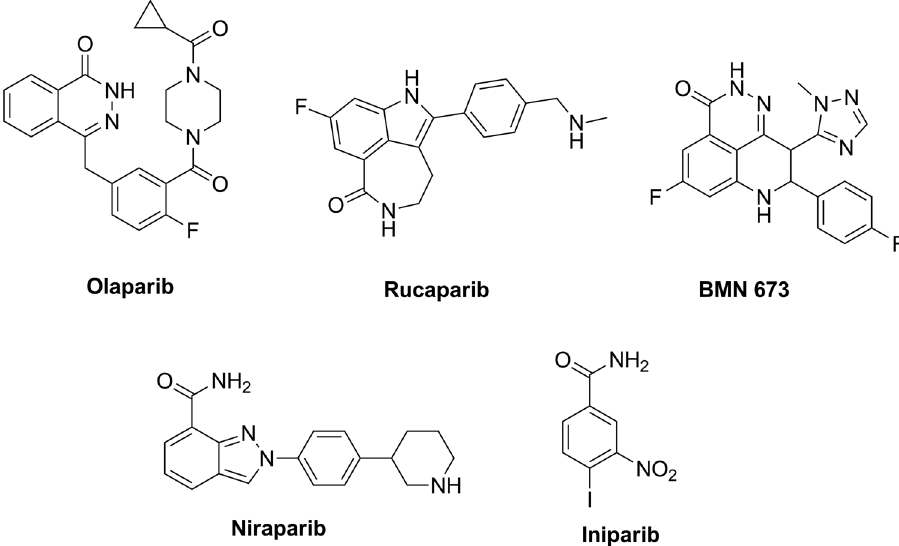
Figure 1. PARP inhibitors in clinical